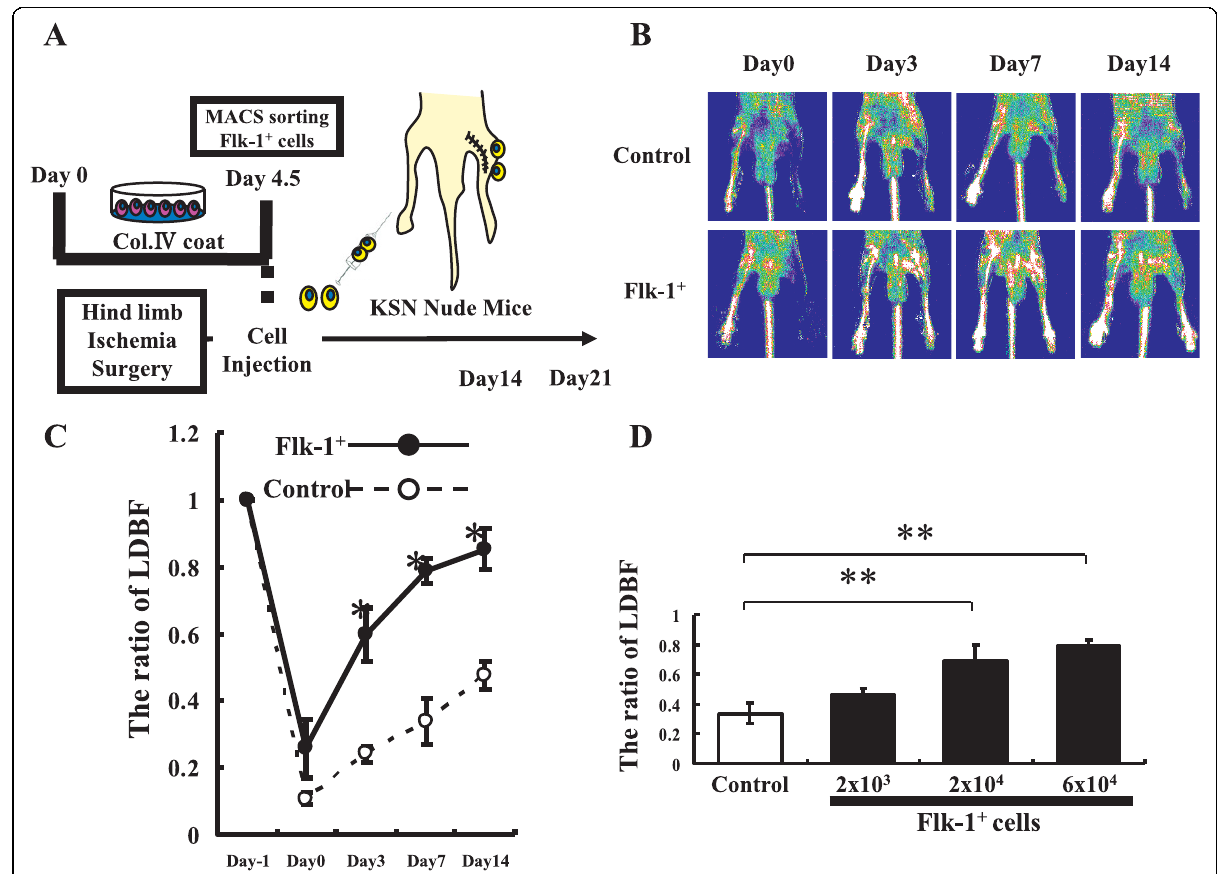
Figure 4 Effects of cell transplantation on blood flow recovery in the ischemic hind limb . A) Strategy to purify Flk-1 + cells and to transplant them into ischemic hind limb tissues. B) Representative LDBF images. A low perfusion signal (dark blue) was observed in the ischemic left hind limb of control mice, whereas high perfusion signals (white to red) were detected in Flk-1 + cell-transplanted animals (6 × 10 4 cells) on postoperative days 3, 7 and 14. C) Quantitative analysis of the ischemic/nonischemic limb LDBF ratio on pre (Day-1) and post operative days 0, 3, 7 and 14 (n = 4). *p < 0.05 Flk1 + cells (6×10 4 ) injected mice vs. control mice. D) Cell dose-dependent effect of transplantation seven days after surgery. Flk-1 + cells (2 × 10 3 , 2 × 10 4 or 6 × 10 4 cells) or PBS as a control were injected into the ischemic limb at postoperative day 1 (n = 4/ each group, **p < 0.05 2×10 4 or 6×10 4 vs. control